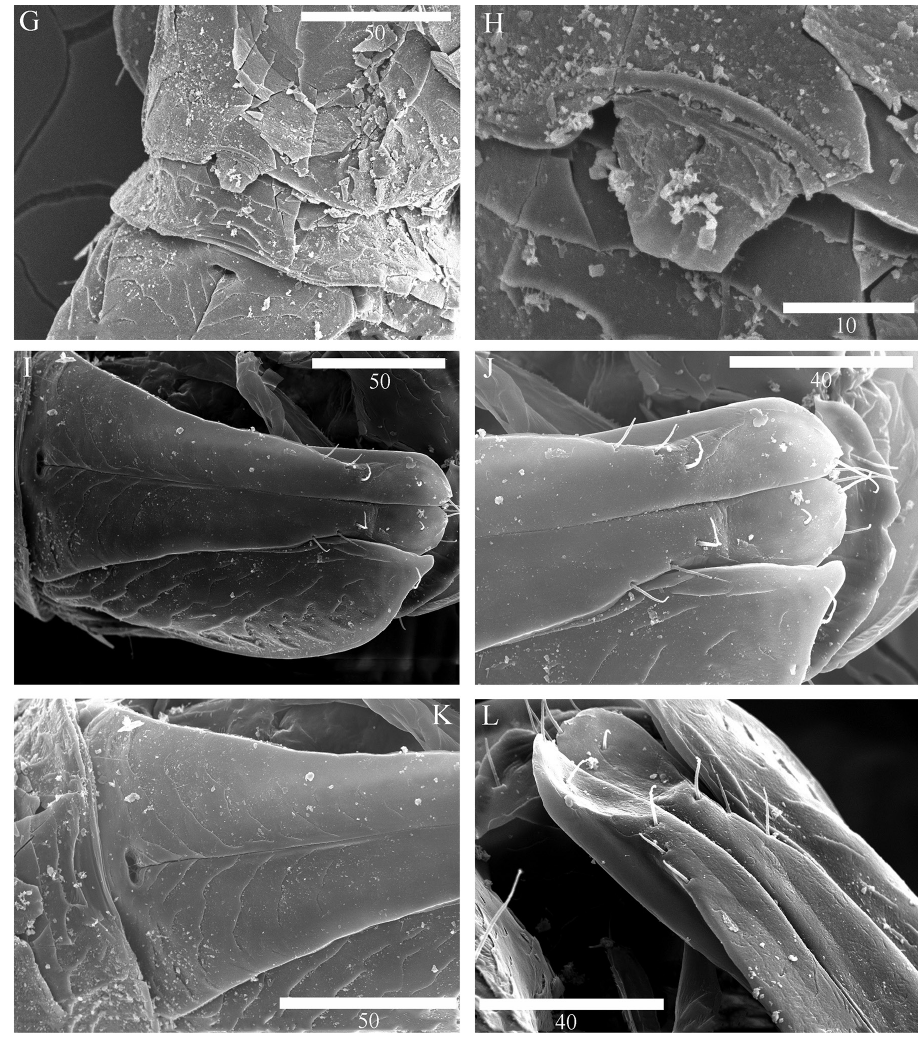
Figure 9. Scanning electron microscope images of Microcharon tanakai sp. n., G pereonite 7 and free ple- onite, ventral, paratype male H penial papillae, ventral, I pleopod 1, dorsal, J distal part of male pleopod 1, dorsal K proximal part of male pleopod 1, dorsal L distolateral view of male pleopod 1. Scale bar unit µm. two claws (Fig. 8E), two pairs of setae on both dorsal and ventral margin (vs pereopod 1 with three simple, two simple setae on both dorsoventral margin